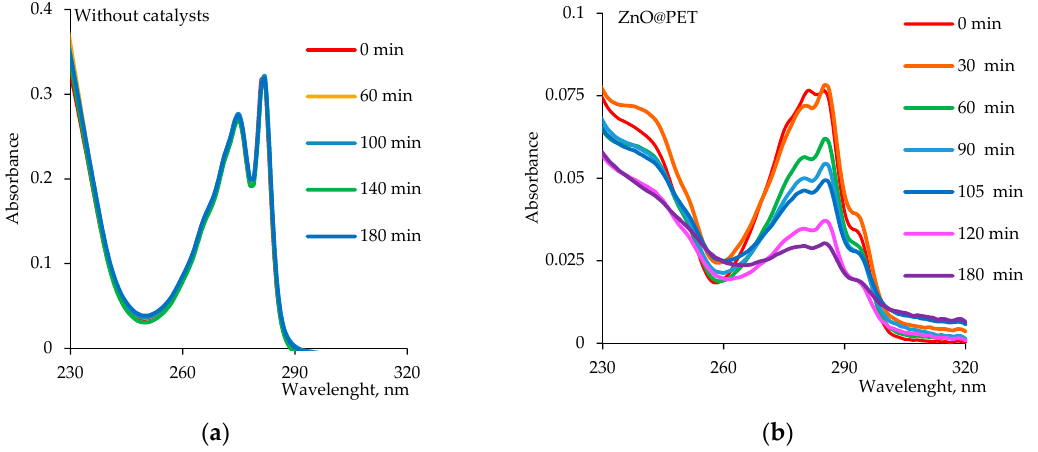
Figure 7. UV–vis absorption spectra of Czm (1.0 mg/L) as a function of time ( a ) without any catalyst and ( b ) in the presence of the 2 × 2 cm 2 ZnO@PET composite membrane catalyst. The time-dependent photodegradation efficiency of Czm in the presence of the same amount of composite catalysts (2 × 2 cm 2 ), taking into account the maximum absorbance peak around 285 nm, is shown in Figure 8a. After 140 min of irradiation, 65.3% and 86.4% of the pesticide were degraded in the presence of Cu 2 O@PET and ZnO@PET catalysts,